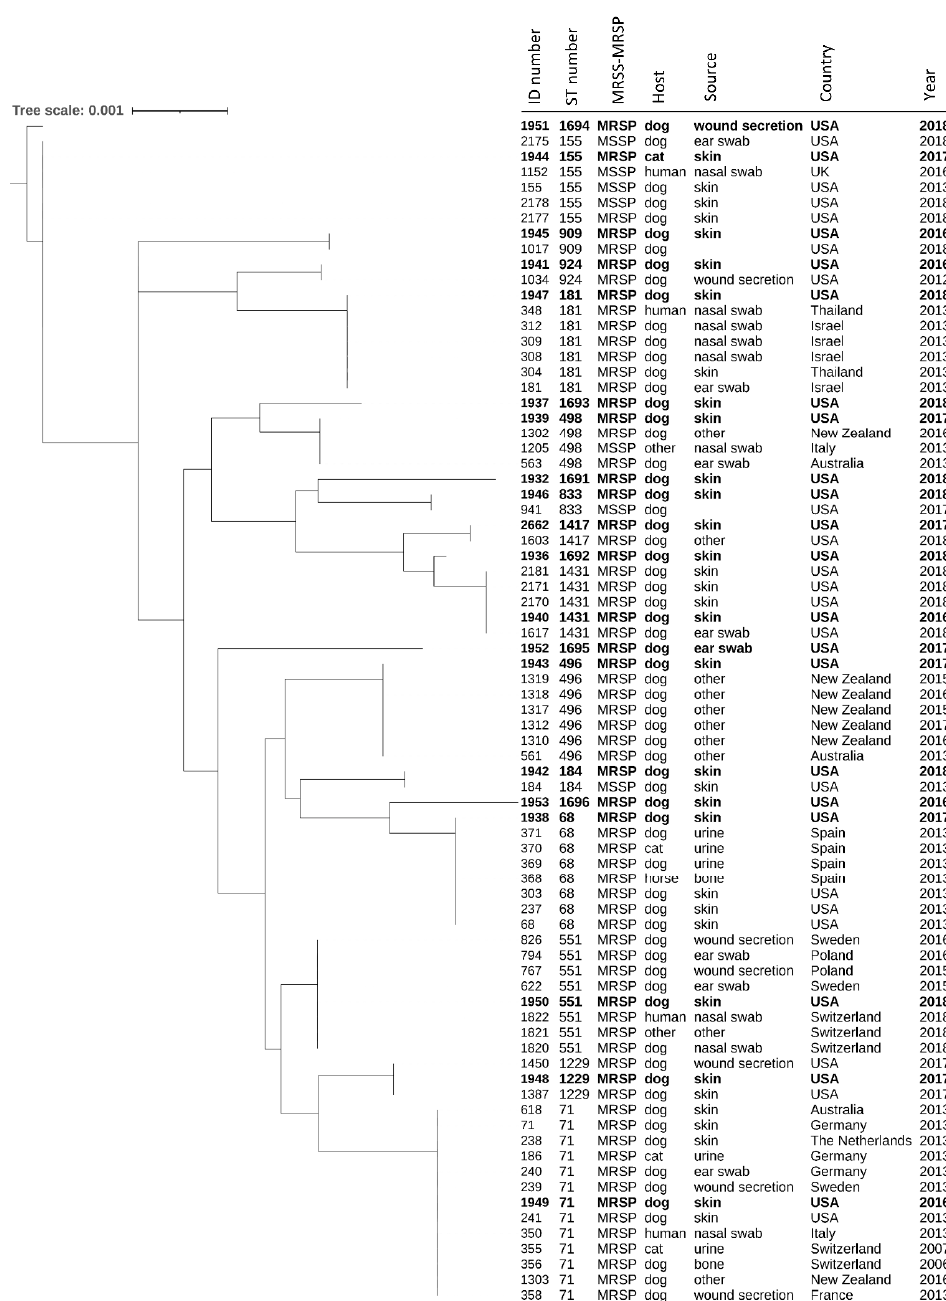
Figure 4. MLST-based dendrogram of the S. pseudintermedius STs found in the current study and their distribution on a global scale, as available in the PubMLST database. The isolates from this study are shown in boldface. The dendrogram was generated without the branch lengths and contained six datasets (PubMLST ID number, ST number, MRSP-MRSS phenotype, host, source, country, and year) using iToL (https://itol.embl.de/, accessed date 15 January 2022). In order to provide a comprehensive view, all isolates of the matching STs available in the PubMLST database (as of January 2022) were included in the dendrogram, except for ST71. For this particular ST, only 13 representative isolates (selected based on host, source, and country) from the total 54 available in the database were included for simplicity. For the STs found in this study, only one isolate (the ones submitted to the PubMLST database) per ST was included in the dendrogram. MRSP: methicillin-resistant S. pseudintermedius ; MSSP: methicillin-susceptible S. pseudintermedius .